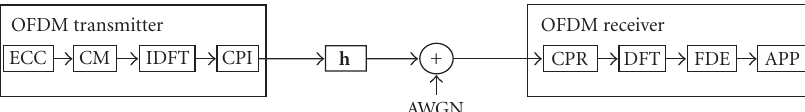
Figure 1: Standard OFDM system model: ECC, outer error correcting code encoder; CM, constellation mapping; (I) DFT, (inverse) discrete Fourier transform; h , channel impulse response; CPR, cyclic prefix removal; FDE, frequency domain equalizer; APP, outer code posterior probability decoder.